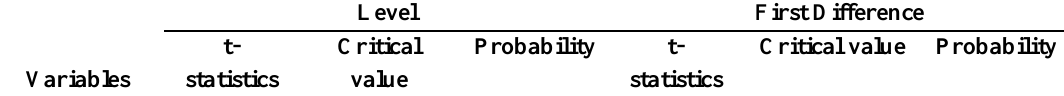
Table.1. Stationary Test (ADF)